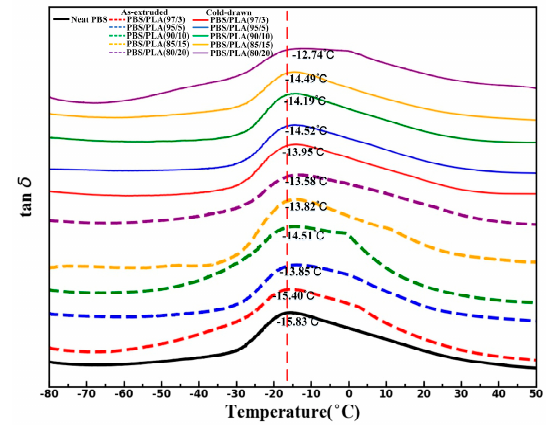
Figure 6. DMA curves of the neat PBS, the as-extruded PBS/PLA composites and the cold-drawn PBS/PLA composites.